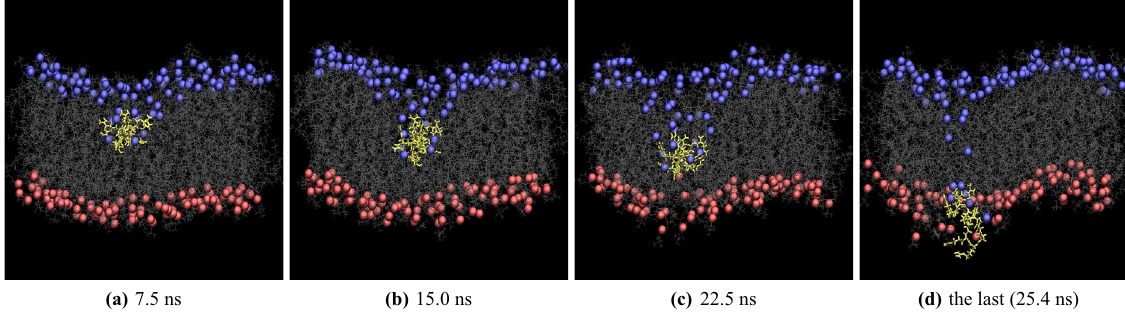
Figure 2. Snapshots at ( a ) 7.5 ns, ( b ) 15.0 ns, ( c ) 22.5 ns, and ( d ) the last (25.4 ns). (yellow: Arg 9 , grey: lipids, blue & red: phosphorus atoms of the upper leaflet & lower leaflet, respectively).